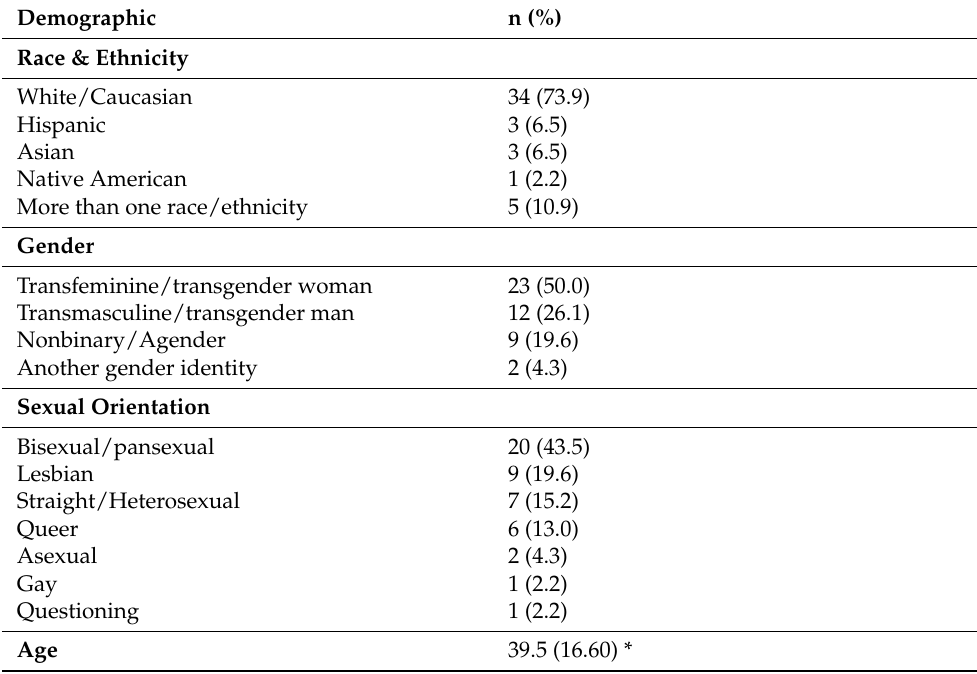
Table 1. Study sample demographics (n =